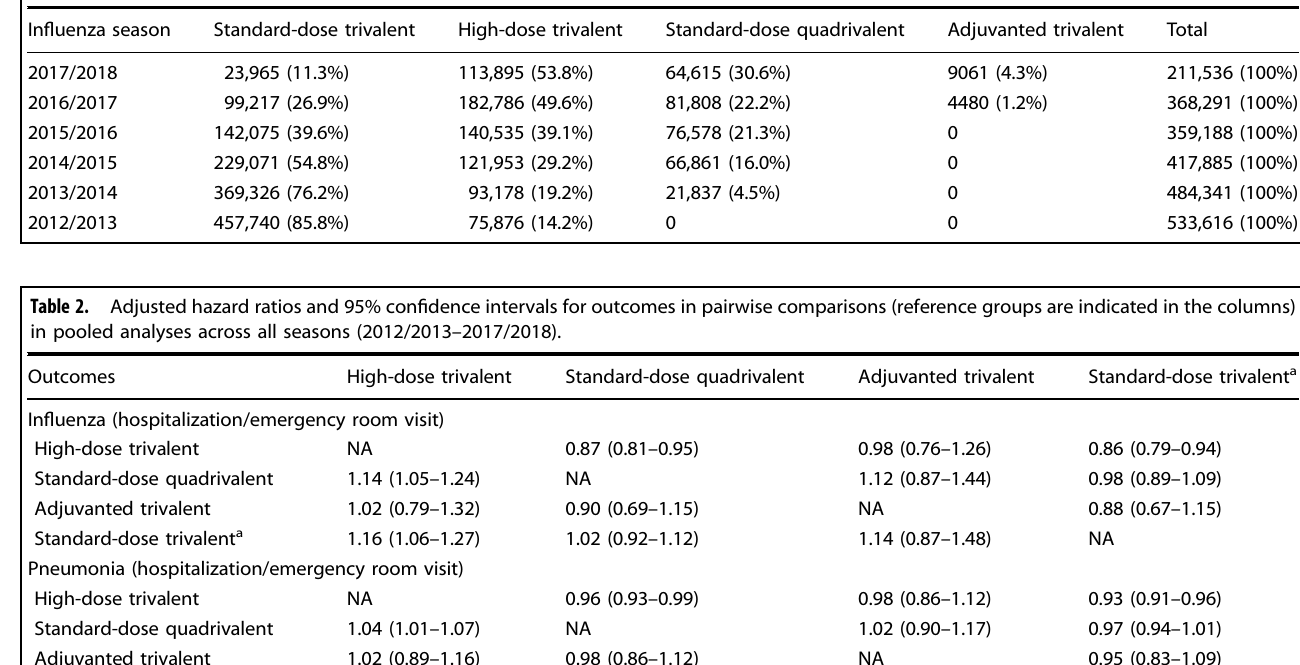
Table 1. Number of subjects selected in each in fl uenza season and distribution of in fl uenza vaccine type.